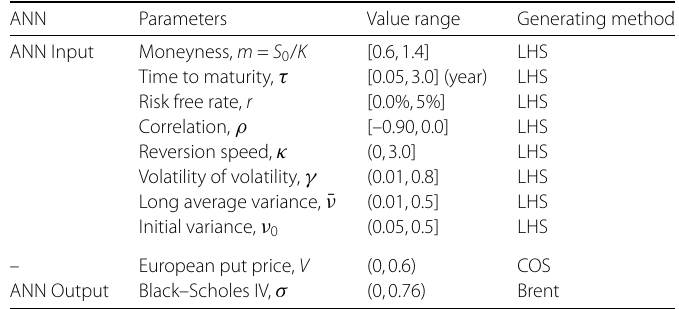
Table 3 Sampling range for the Heston parameters. LHS means Latin Hypercube Sampling, COS stands for the COS method (see the Appendix) and Brent for the root-finding iteration